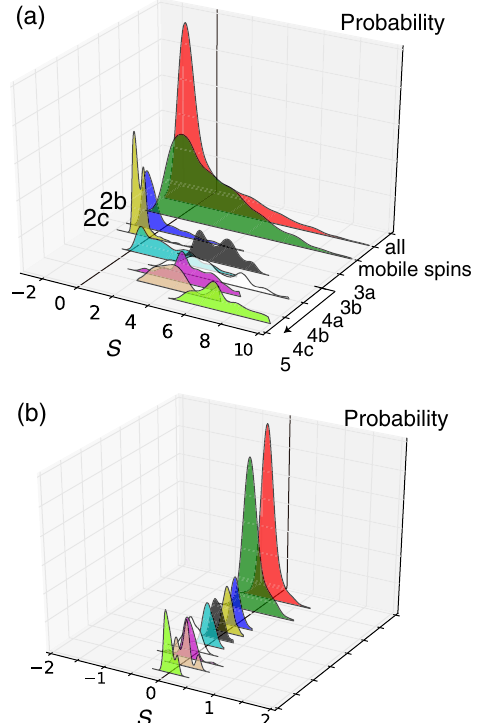
FIG. 8. Softness distributions. The distributions of S of all spins, mobile spins with facilitation, and local motifs at (a) 25 . 3 °C and (b) 27 . 1 °C. The curves of local motifs are rescaled by 25% for clarity.